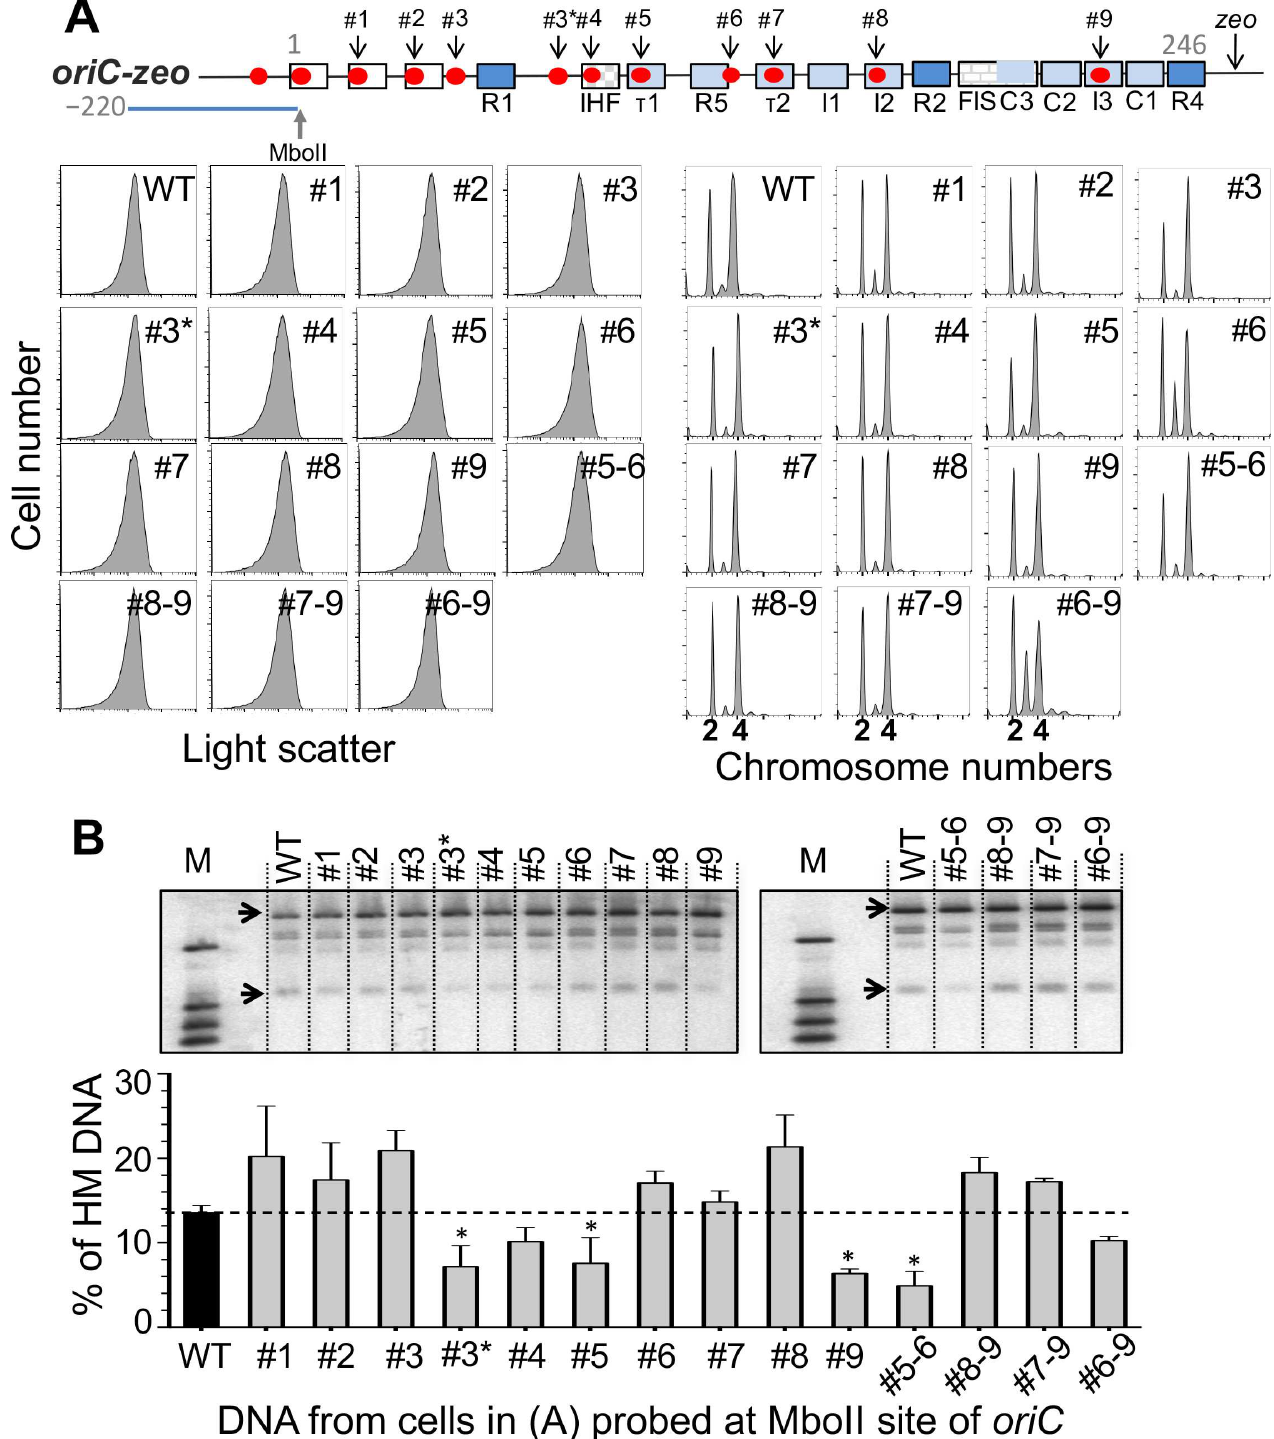
Fig 4. Effect of GATC mutations in oriC on initiation synchrony and the level of HM DNA at the MboII site of oriC . (A) The top line shows a schematic map of oriC as in Fig 1B except for an additional GATC site (#3 * )includedin this study. In these experiments oriC was marked with a zeo drug R cassette. GATC sites at positions#1–9 and #3 * were individuallymutated to GTTC and the mutant cells were analyzedby flow cytometry as in Fig 3A before and after replicationrun-out. Cells were also studied after combiningsome of the mutations(#5–6 etc.). (B) HM DNA levels as in Fig 2A except that the levels were measuredat the MboII site for all. The black bar representsthe HM DNA level in the WT strain (